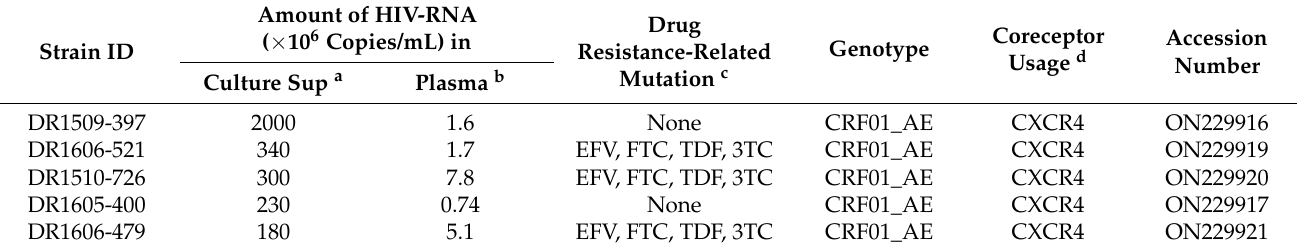
Table 1. Characteristics of seven representative strains tested for drug